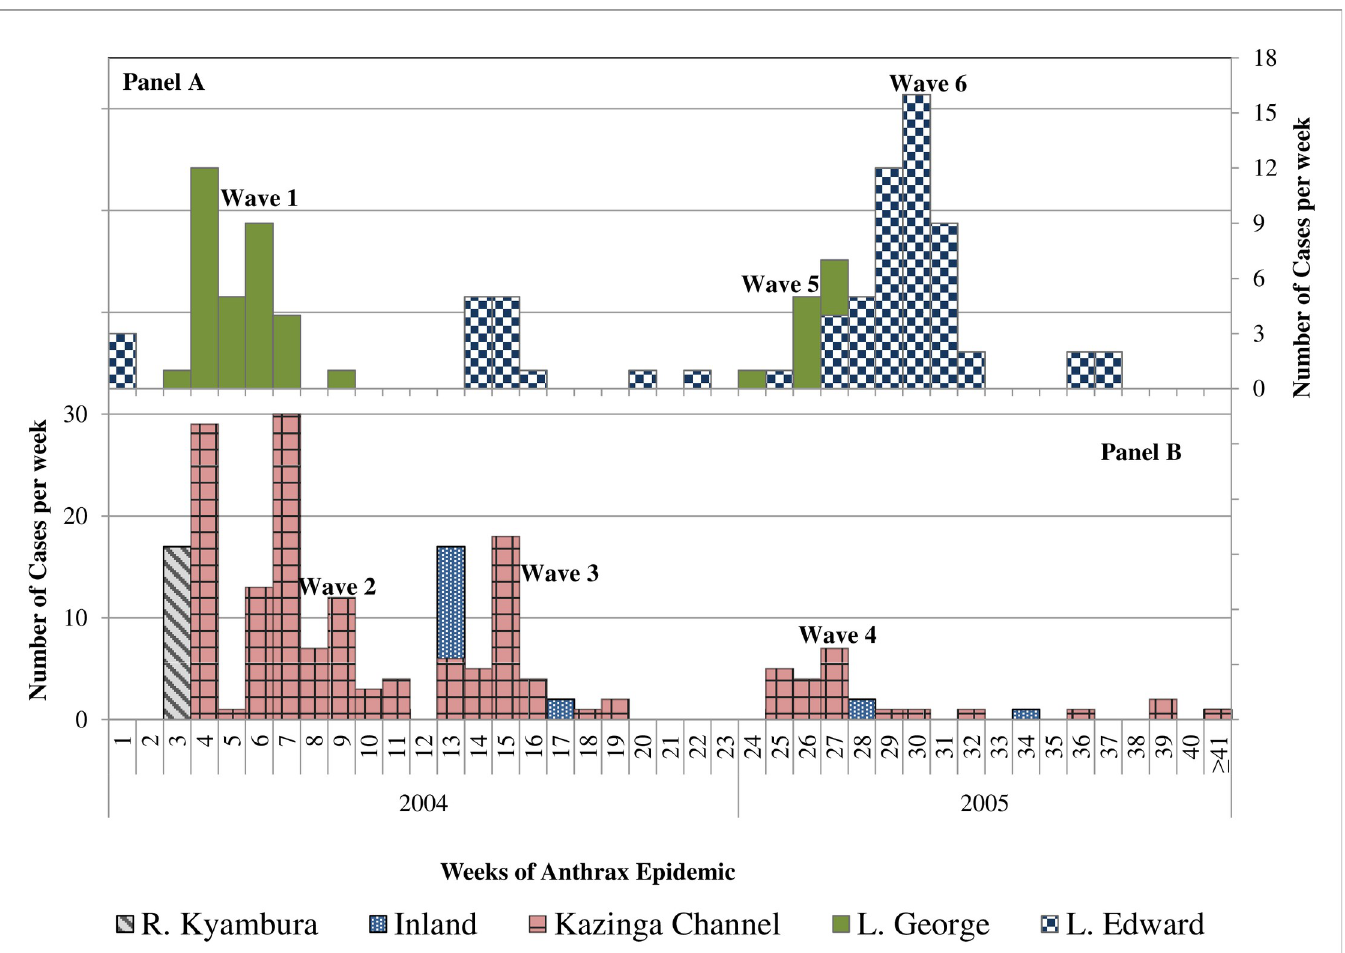
Fig 7. Location specific patterns of epidemic spread for weekly Hippopotamus anthrax cases in 2004/5. Epidemic curves were characterized by geographical locations at Lakes George and Edward (Panel A); Kazinga channel and R. Kyambura (Panel B) to examine possibilities of occurrence of a series of sporadic point source outbreaks. Epidemic waves detected were numbered 1–6 according to the sequence of occurrence of waves at the respective locations. Epidemic patterns remained clustered, progressing successively and waves lasted beyond one incubation period of anthrax (average 1–14 days) except at Kyambura River.